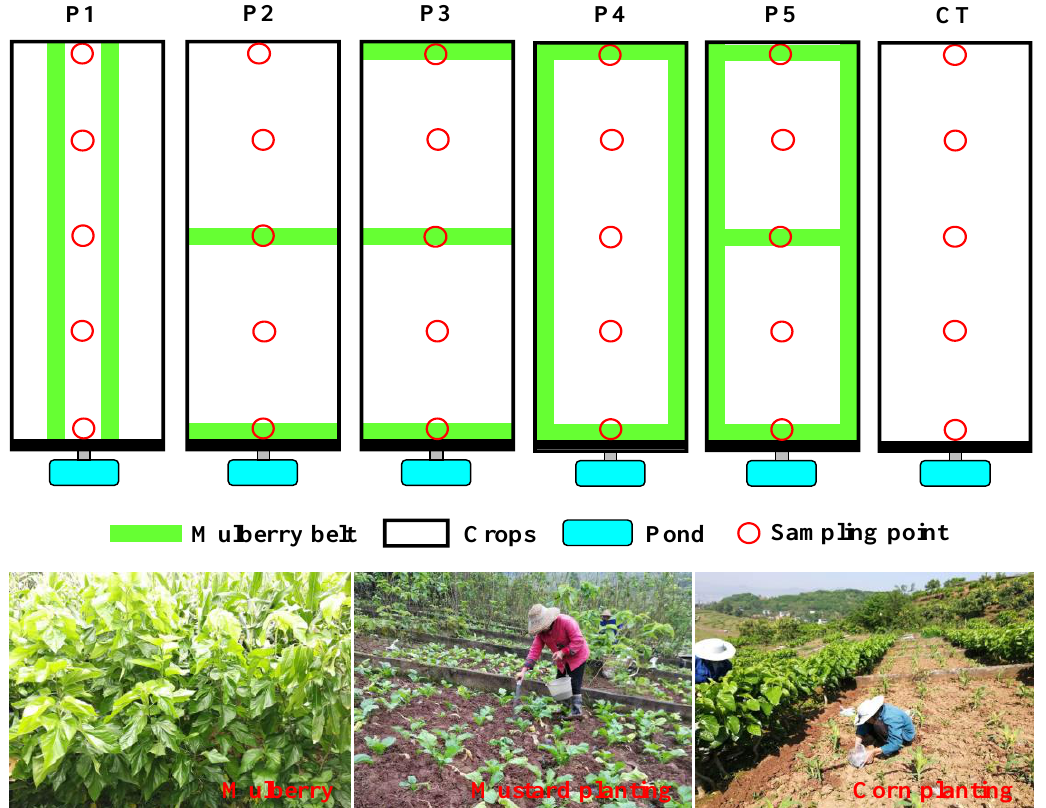
Figure 2. Schematic diagram of different crop-mulberry configuration patterns. P1: two longitudinal mulberry hedgerows; P2: two mulberry contour hedgerows; P3: three mulberry contour hedgerows; P4: mulberry hedgerow border; P5: mulberry hedgerow border and one mulberry contour hedgerow; CT: no mulberry hedgerows, as a control. The width of each mulberry belt was 0.5 m.